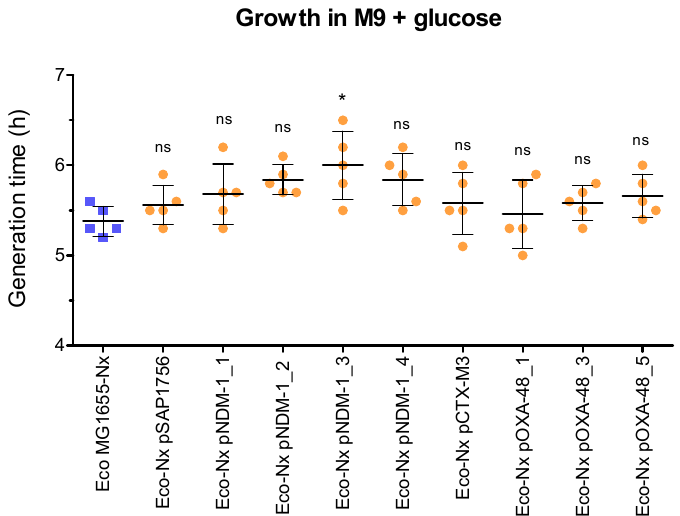
Figure 4. Generation time of E. coli MG1655 (resistant to nalidixic acid) in hours, with (orange circles) or without (blue squares) IncL/M plasmids, calculated during the exponential phase of growth in M9 minimal media supplemented with glucose. The differential growth of the host without and with plasmid represents the burden of the plasmid under these conditions. Horizontal lines show the mean and vertical lines the standard deviation of at least 5 independent experiments. One-way analysis of variance with Dunnett’s post hoc test was performed between the bacterial hosts with plasmid versus the control without plasmid (*: p < 0.05; ns: no significant